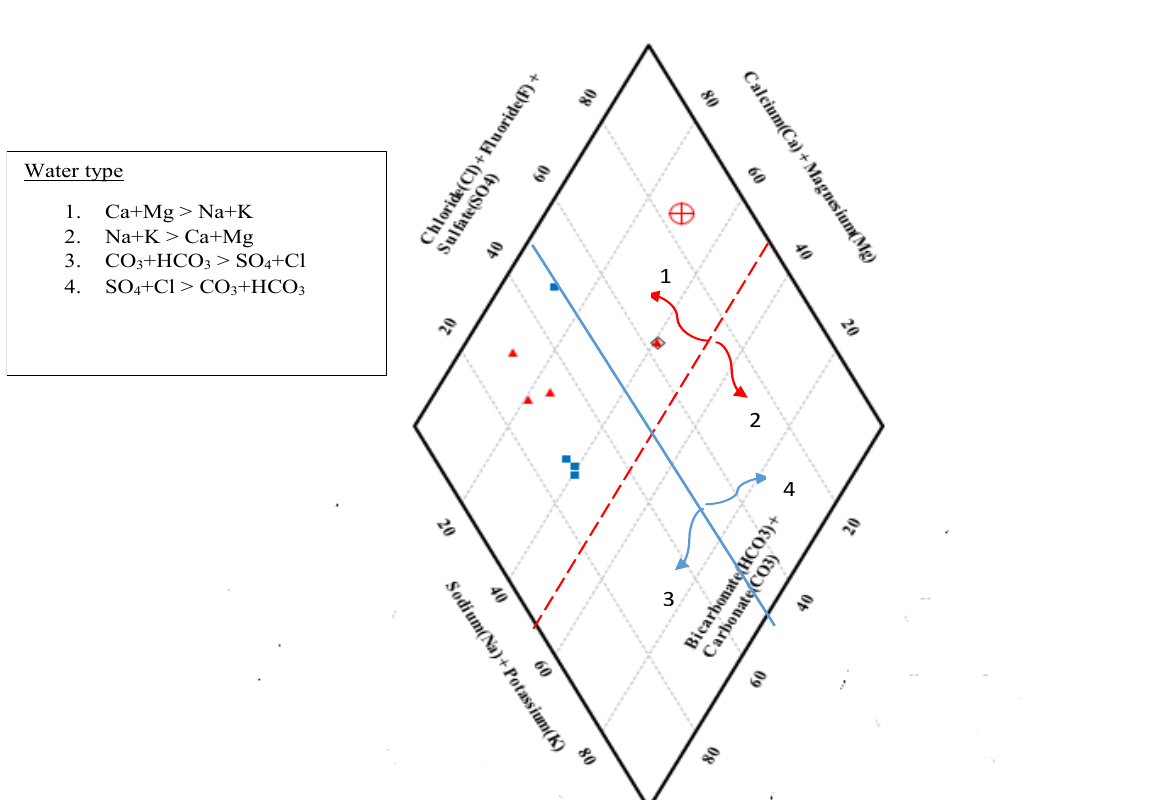
Figure 4. Piper diagrams for the chemical composition of groundwater samples